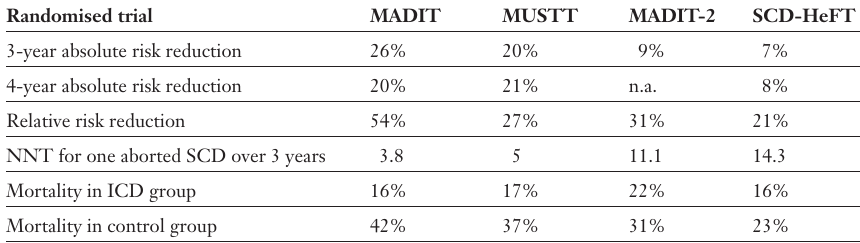
Mortality rates and risk reductions based on four primary pre- vention ICD